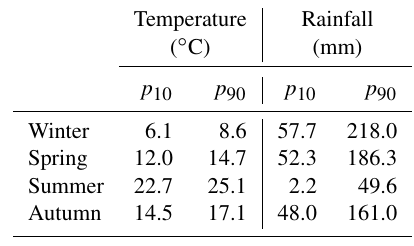
Table 3. Calibration of the reconstruction methodology using 25- year moving series from 1895 to 2005. u : mean value; SD: standard deviation; RMSE: root-mean-square error; r : correlation coefficient between observed and estimated parameters.